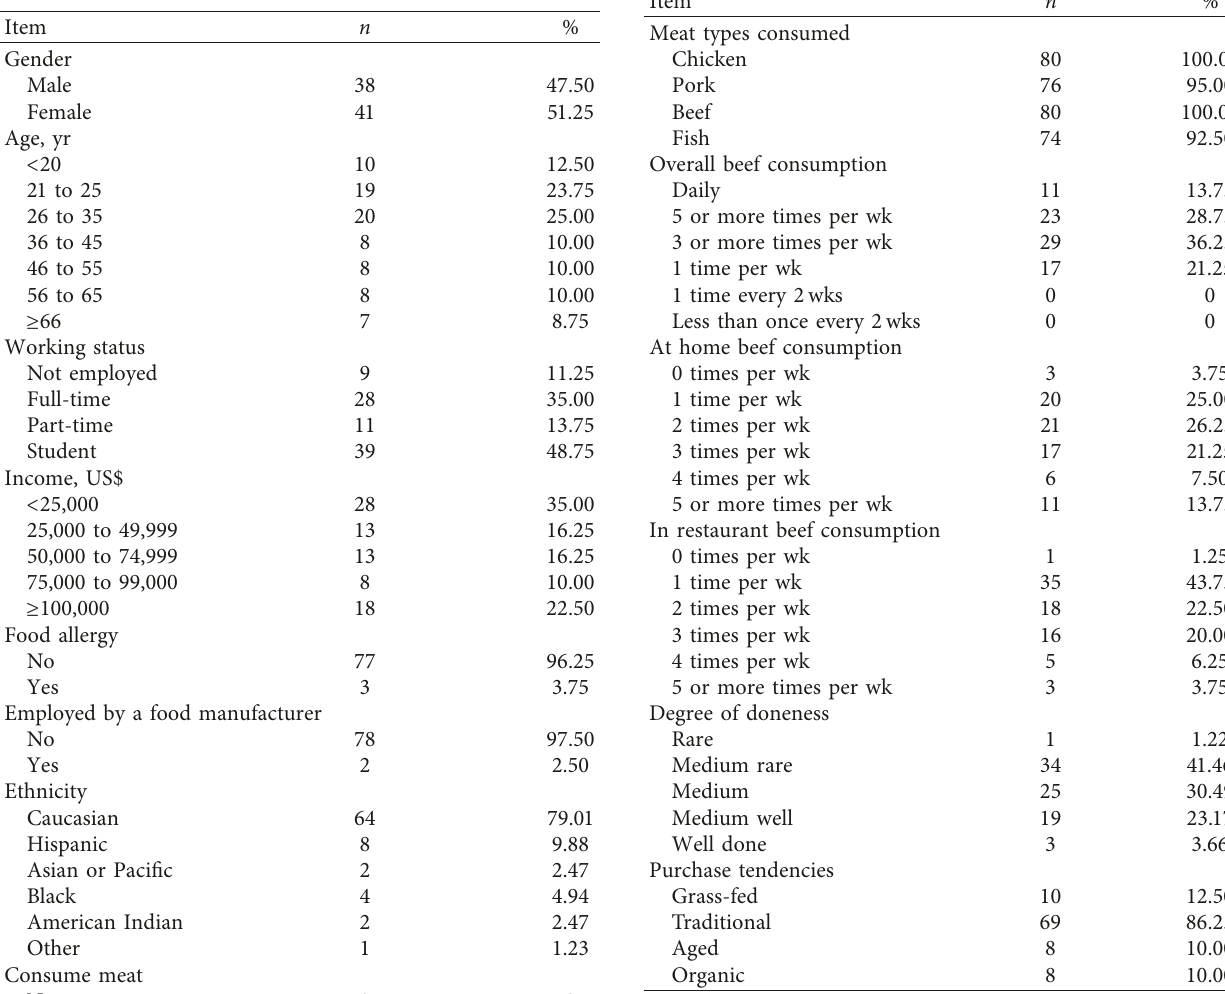
Table 1: Demographic attributes of consumers that participated in the sensory panels.